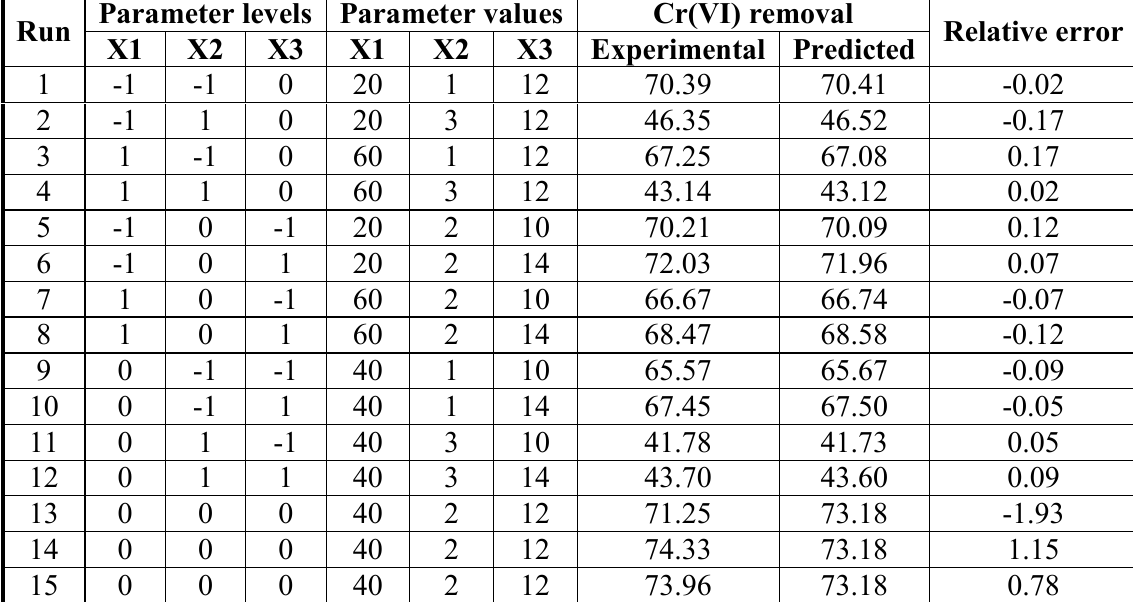
Table 2. Results of chromium (VI) removal by response surface methodology.